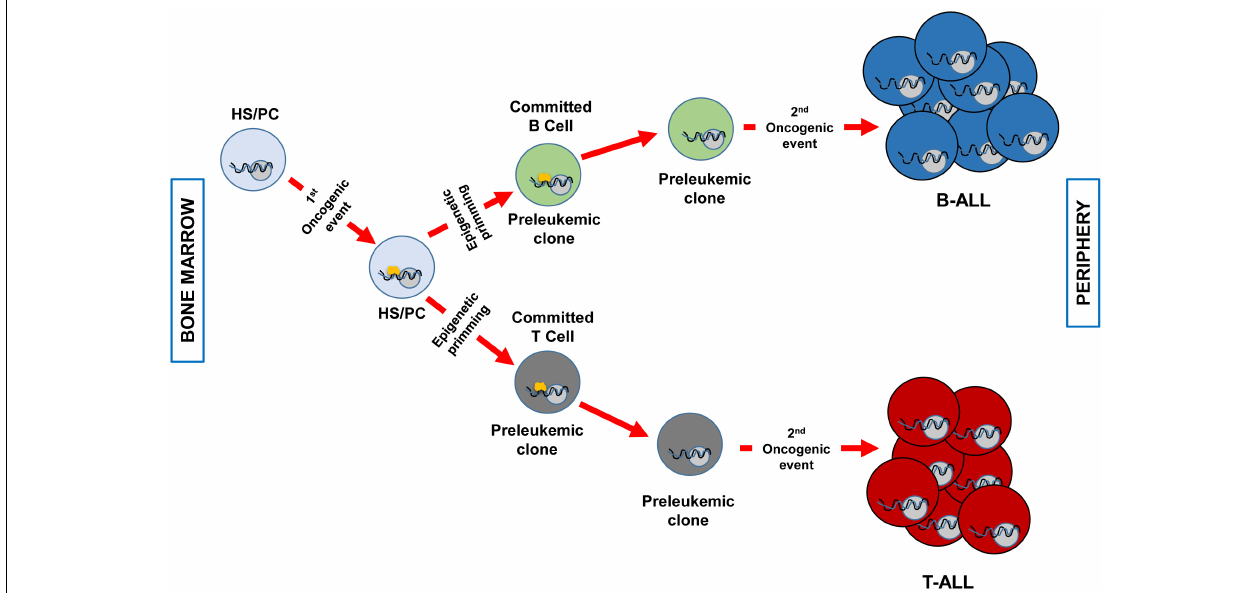
FIGURE 1 | Clonal evolution of B and T-ALL imposed by epigenetic priming in genetically predisposed mouse models. The first genetic event that takes place in an HS/PC induces specific epigenetic priming that will determine the commitment of the preleukemic clone phenotype. For example, ETV6-RUNX1 (Rodriguez-Hernandez et al., 2017) or BCR-ABLp190 (Martin-Lorenzo et al., 2018) expression will prime a B-cell commitment, whilst the overexpression of LMO2 will command T-cell priming (Garcia-Ramirez et al., 2018). Afterward, a second hit will transform the preleukemic clone in a fully transformed leukemic cell (B o T). At this stage, the first genetic event (represented in yellow) is not required anymore and has already primed the cell-of-origin into a specific differentiation cell program. A less efficient epigenetic priming could also occur in a more differentiated cell compartment as it has been described for LMO2 in T-ALL (Garcia-Ramirez et al.,